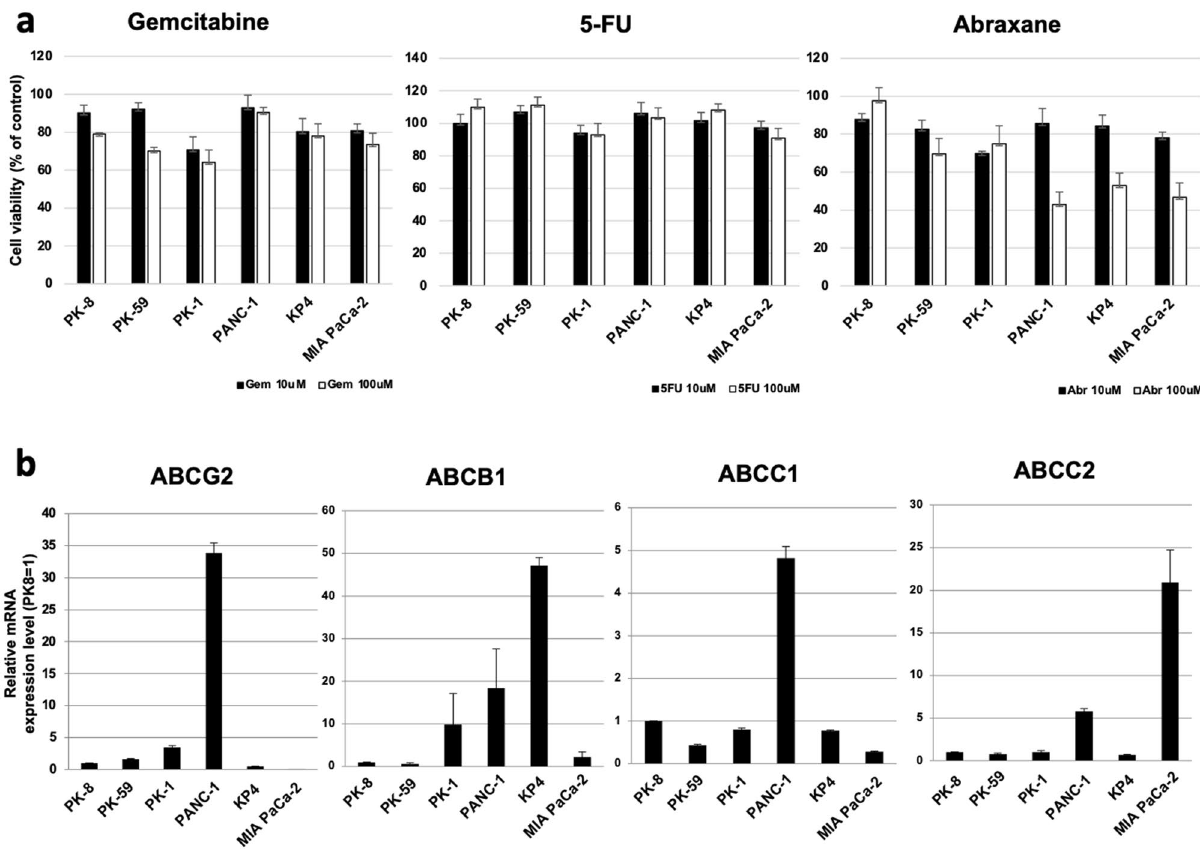
Figure 5. Effects of anticancer drugs on the viability of PDAC cells. ( a ) Anticancer drug resistance assay in 3D cultures of 6 PDAC cells. The dose responses (10 or 100 μM) of the cells to gemcitabine, 5-FU, and abraxane were determined using the ATP assay. Results are presented as the means ± SD from three independent experiments. ( b ) qRT-PCR analysis of transporters in the 6 PDAC cells in 3D culture . Results are presented as the means ± SD from triplicate measurements. The results are shown after normalization to the values obtained for PK-8 cells (value =